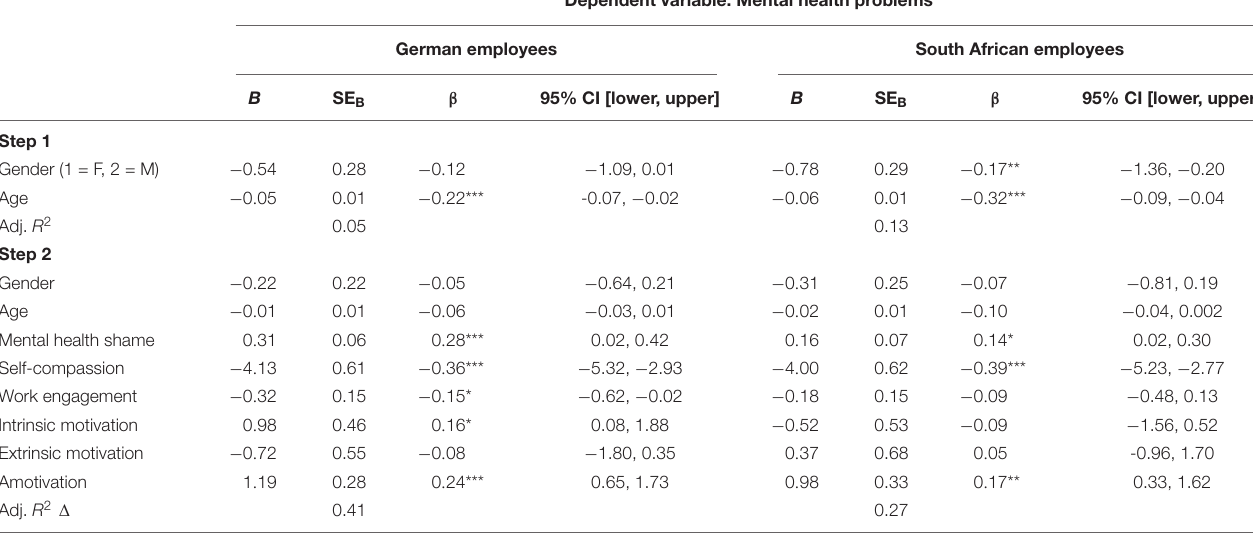
TABLE 3 | Multiple regressions: Mental health shame, self-compassion, work engagement, and work motivation for mental health problems in German and South African employees. Dependent variable: Mental health